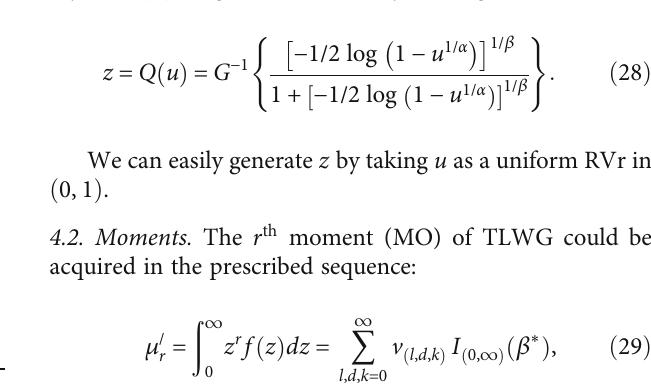
Table 5: Statistic for the survival time data.